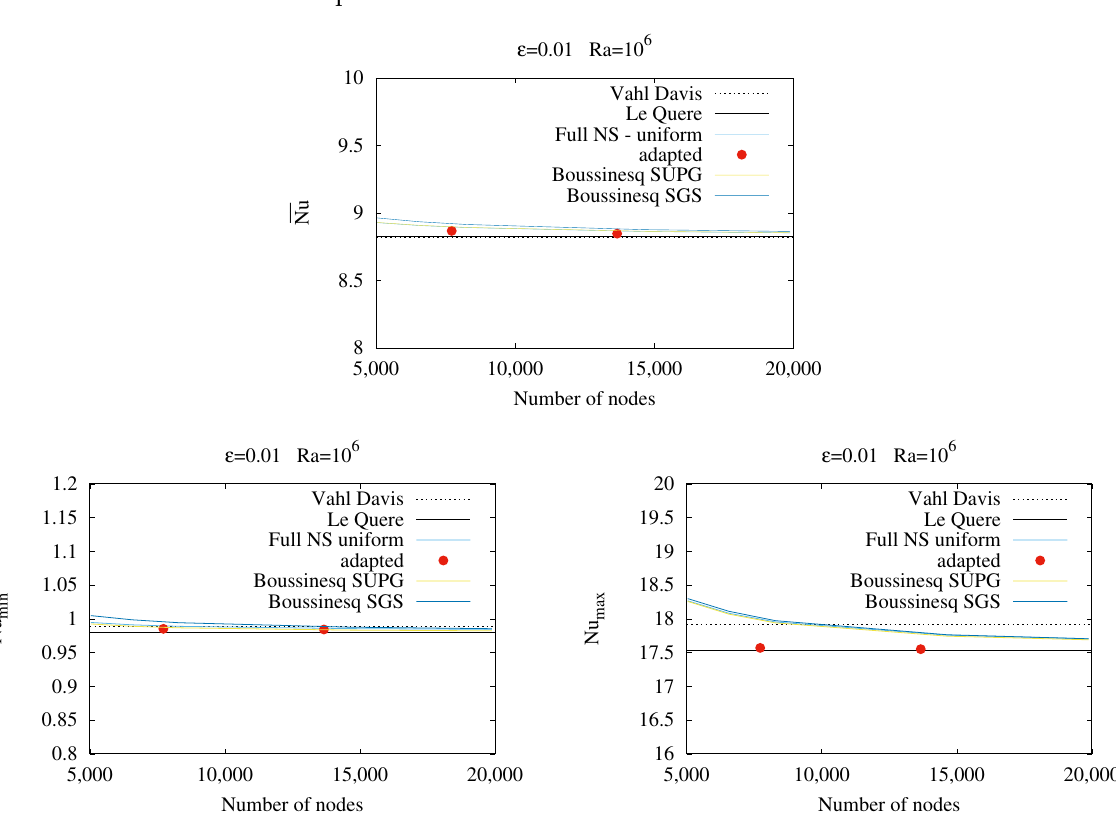
Figure 10. Buoyancy-driven square cavity. Adapted solutions for (cid:101) = 0.01 obtained with various methods and the HH